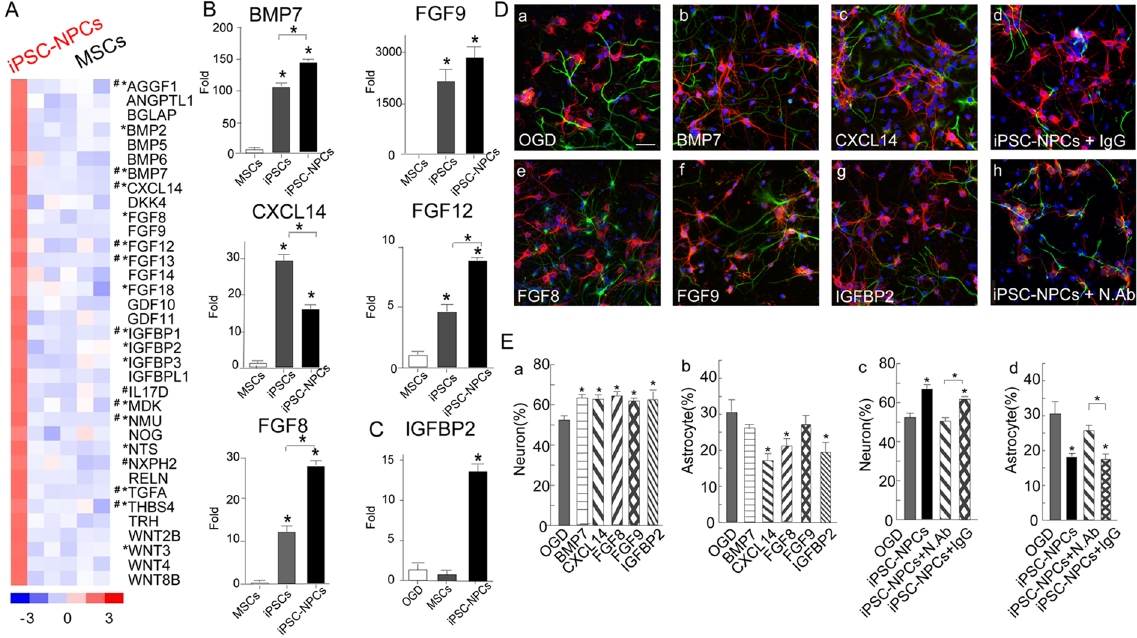
Figure 5. The unique secretome from human iPSC-NPCs. ( A ) A heat map shows differences between the secretomes of iPSC-NPCs (Lane 1, clone 201, GEO accession GSE82101, http://www.ncbi.nlm.nih.gov/geo/ query/acc.cgi?acc = GSE82101) and BM-MSCs (Lane 2–6). Genes with # are overexpressed in the iPSCs; genes with * have been previously shown to be overexpressed in other iPSCs compared with BM-MSCs according to published array data. ( B ) Validation of the microarray data by RT-qPCR confirmed the upregulated gene expression of BMP7, CXCL14, FGF12, FGF9, and FGF8 in iPSCs and iPSC-NPCs compared with BM-MSCs. The results are expressed as mean ± standard deviation (SD). ( C ) Cytokine array analysis shows that the supernatants from iPSC-NPC co-cultures were exclusively enriched with IGFBP2 compared to those from BM-MSCs or OGD-injured cultures (Supplementary Fig. 1). ( D ) Immunocytochemistry of OGD-injured cortical cells alone (a) and those treated with BMP7 (100 ng/ml, b), CXCL14 (10 ng/ml, c), FGF8 (100 ng/ml, e), FGF9 (10 ng/ml, f), and IGFBP2 (100 ng/ml, g) shows neuroprotection of the individual cytokines. Note that a neutralizing antibody cocktail (N. Abs, h), including anti-BMP7, anti-CXCL14, anti-FGF9, anti-FGF8, and anti-IGFBP2, significantly abolished the neuroprotection effects from iPSC-NPCs compared with the control antibodies (IgG, d, also Ec,d). ( E ) The results are expressed as mean ± SEM. Scale bar ( D ) = 50 µ m. * P <